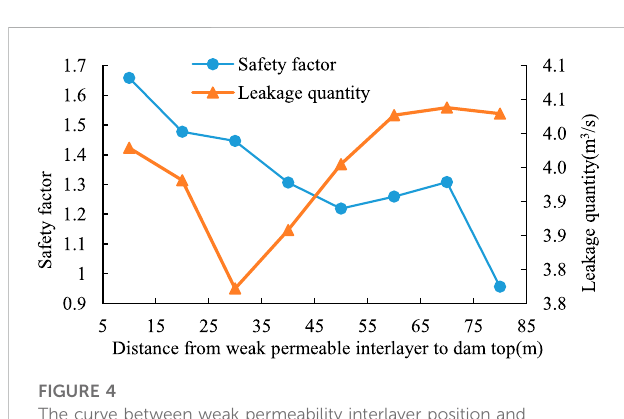
FIGURE 4 The curve between weak permeability interlayer position and leakage with the safety